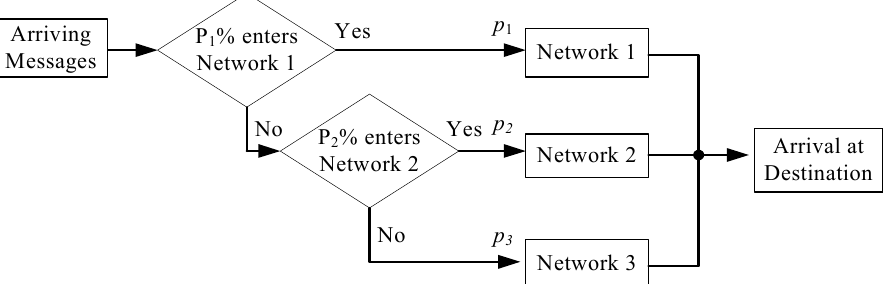
Figure 5. Queueing network design of 3 networks.